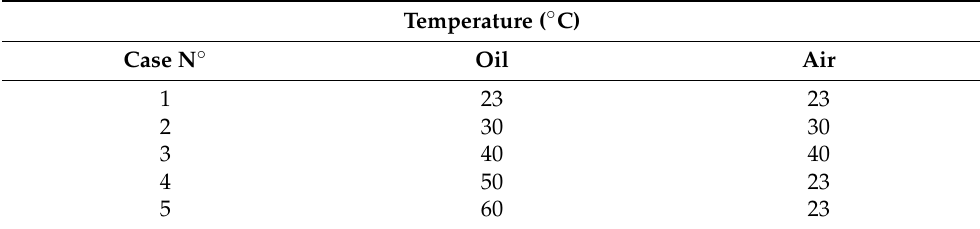
Table 1. Summary of cases examined during the experiment.